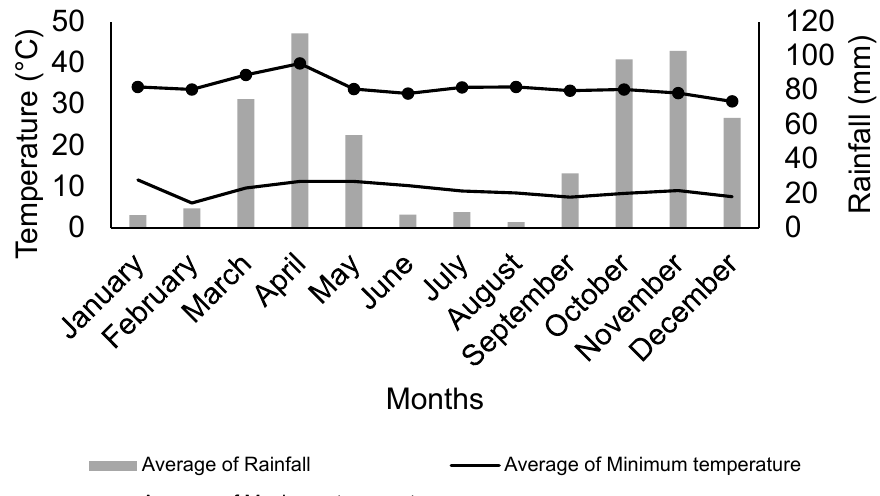
Figure 1. Monthly average temperature (line) and rainfall (bars) behavior in the experimental area for the 20-year period between January and December.